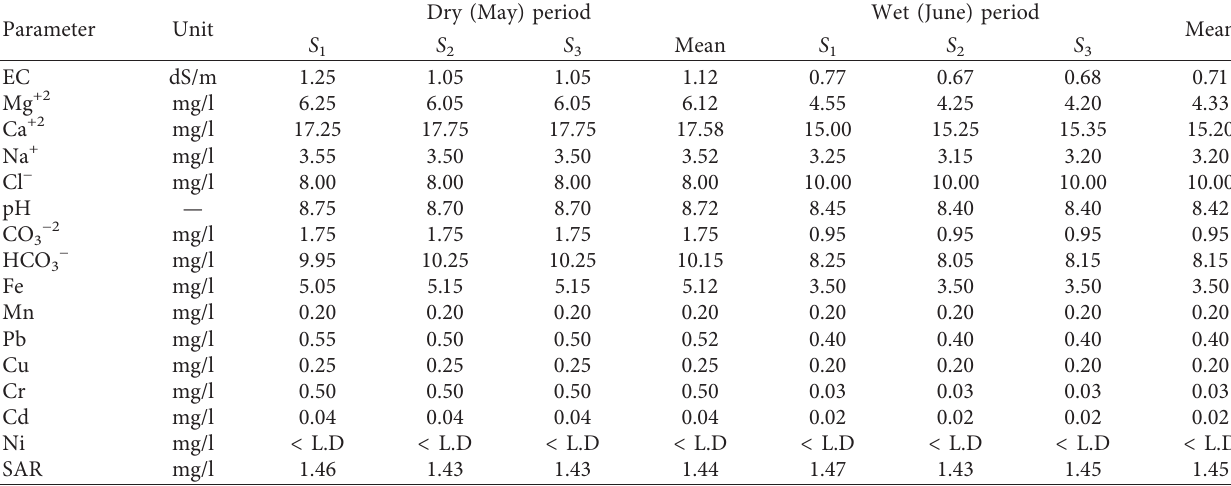
Table 3: Physicochemical characteristics of downstream Borkena water quality during the dry and wet season. Parameter